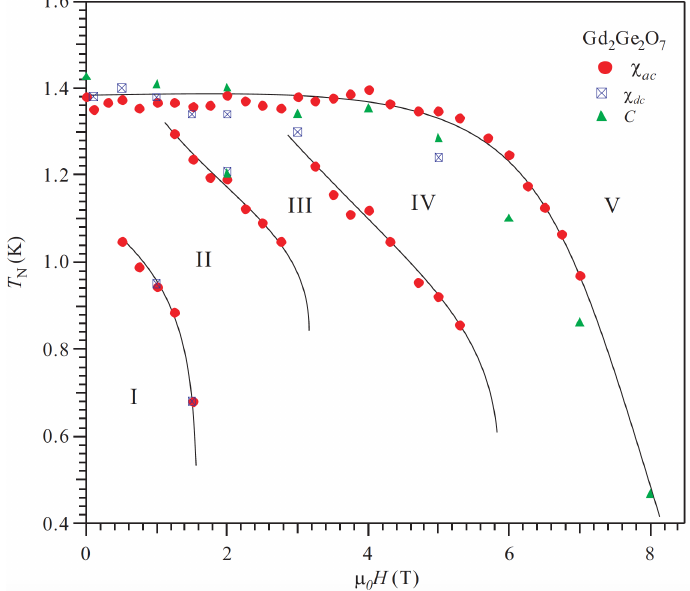
Figure 3. (color online) Magnetic phase diagram for Gd 2 Ge 2 O 7 . From Ref.